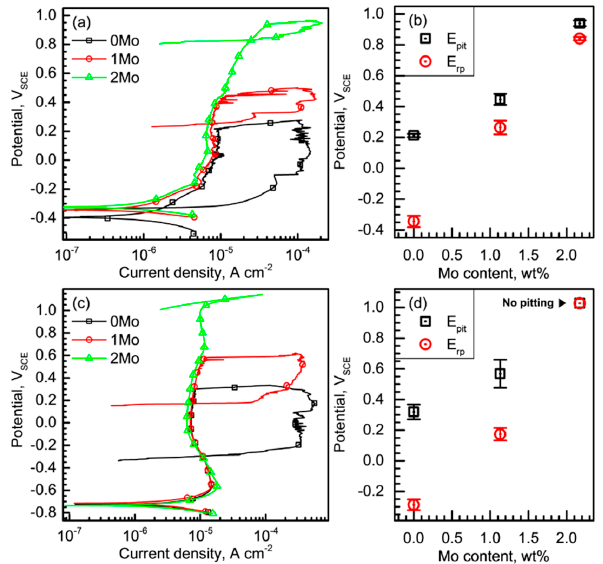
Figure 4. Cyclic potentiodynamic polarization curves of 0Mo, 1Mo, and 2Mo alloys measured in ( a ) 4 M NaCl and ( c ) borate-phosphate-citric buffer containing 4 M NaCl (pH 8.5) solutions at 25°C. (d V /d t = 1 mV/s). Average pitting and repassivation potentials with standard deviation values (scatter band) of the alloys measured in ( b ) 4 M NaCl and ( d ) buffered 4 M NaCl solutions.